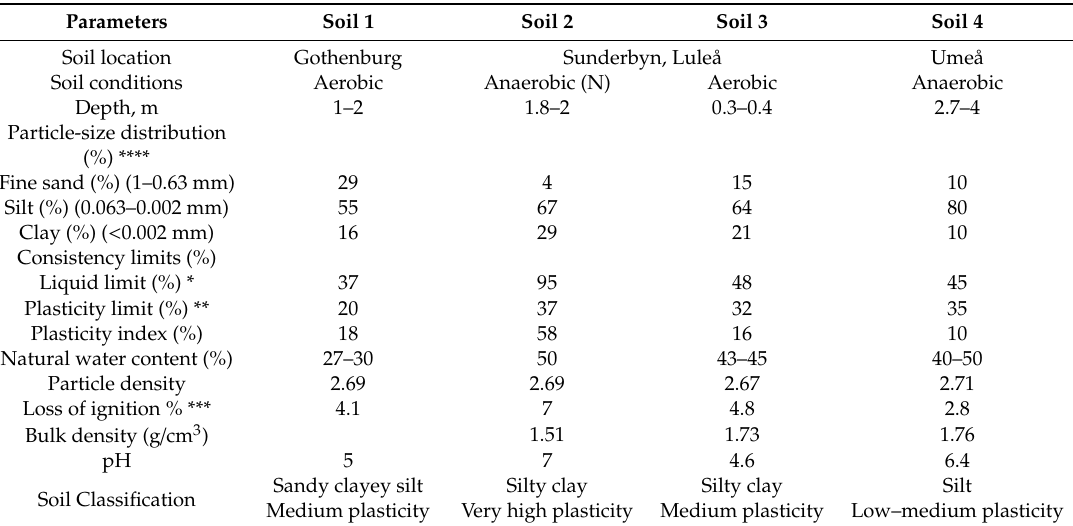
Figure 1. Particle size distribution of four soils type. Table 2. Engineering properties of the four soil types.